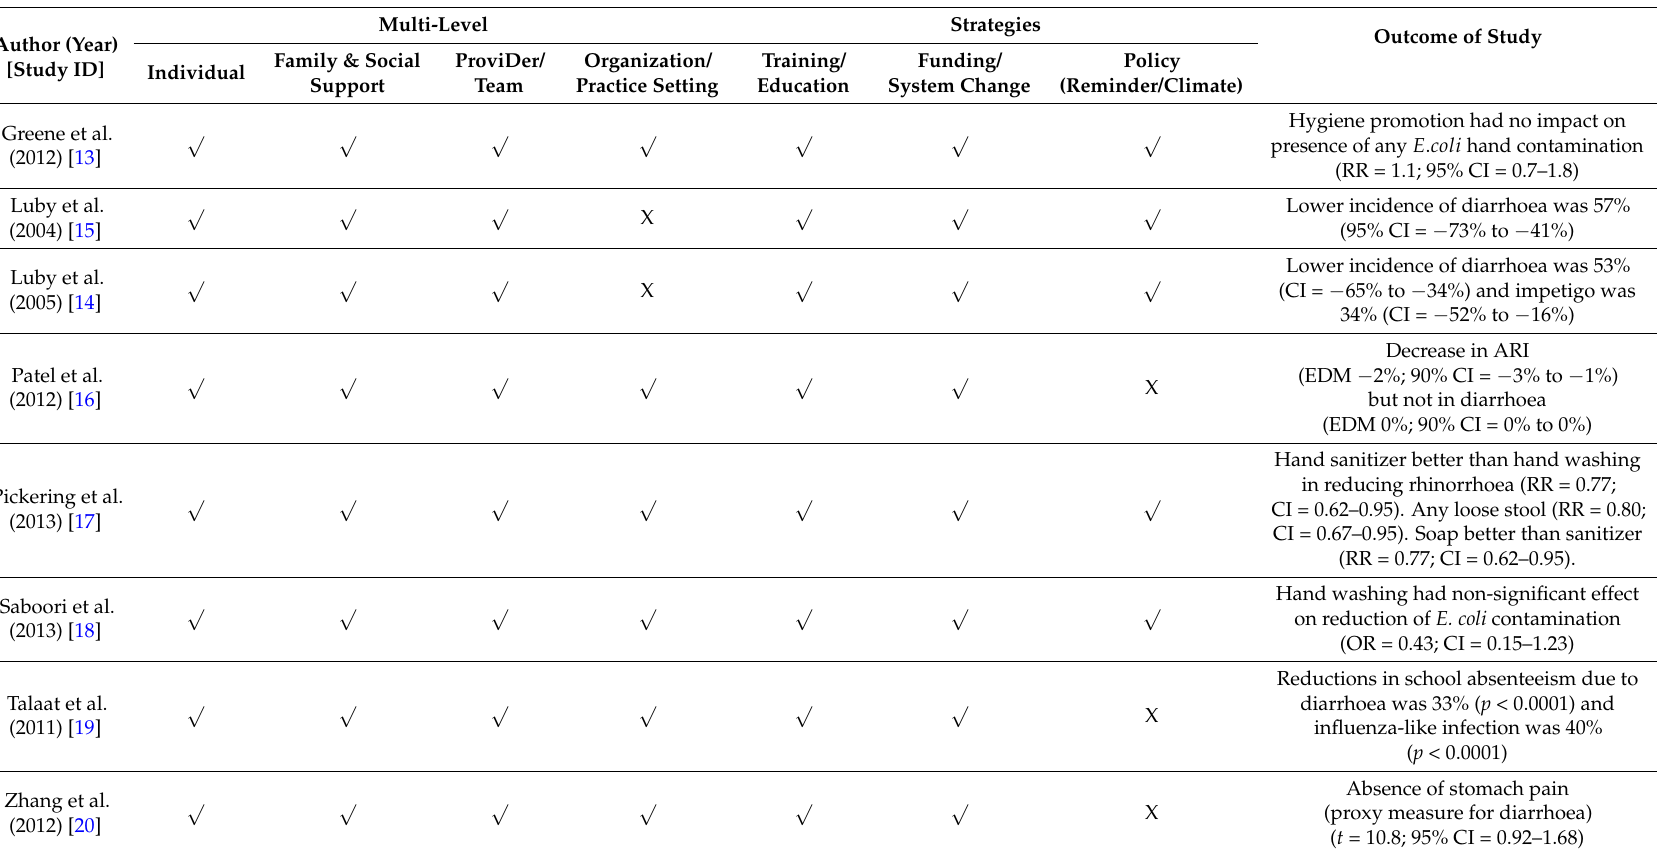
Table 4. Multi-level interventions and strategies used in the included